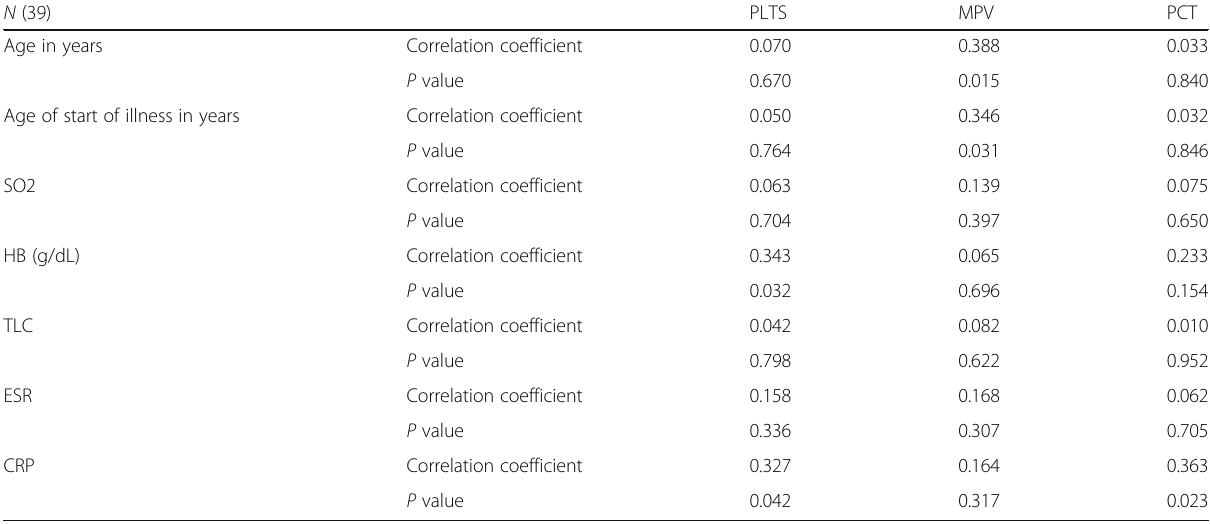
Table 3 Comparison between cases and controls; platelets count, MPV, and plateletcrit findings in relation to other parameters N (39)